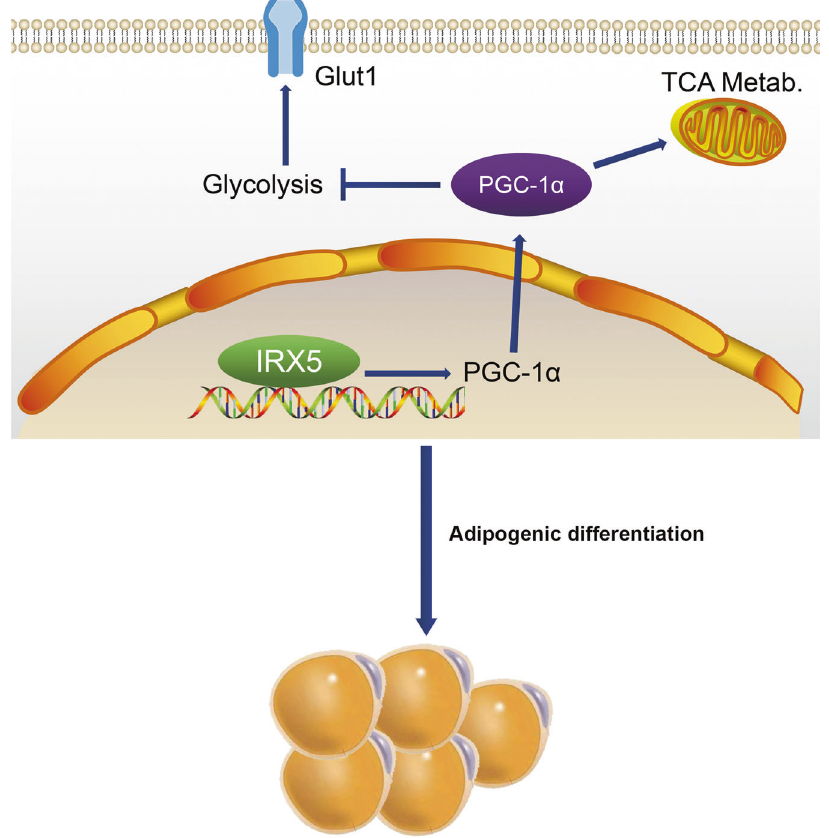
Fig. 8 Schematic diagram of the proposed role of IRX5 in the regulation of adipogenic differentiation of hMSCs. Our results suggested that IRX5 promotes adipogenic differentiation of hMSCs through targeting PGC-1 α and restraining glycolysis. SR-18292, PGC-1 α inhibitor, and metformin, potential glycolysis booster, reversed the effect of IRX5 overexpression on